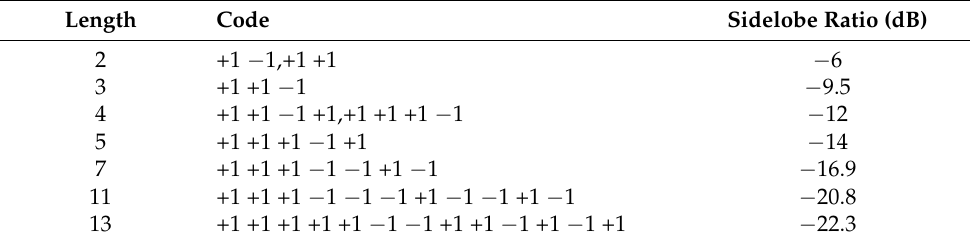
Table 1. Barker codes and their auto-correlation sidelobe level